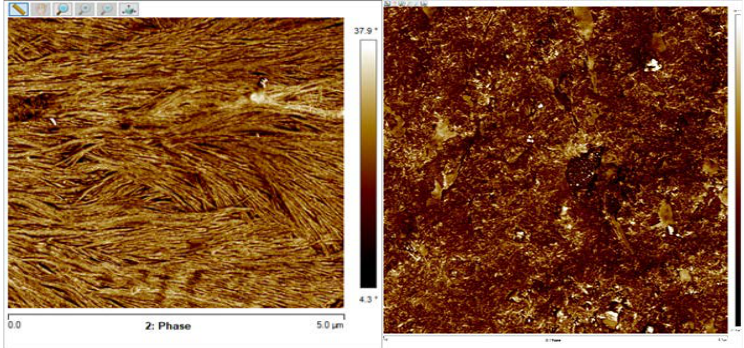
Figure 5. Atomic force microscope images of surface of PUR and its composite with 20 wt.% of Chit ( 8. composite ) [36].